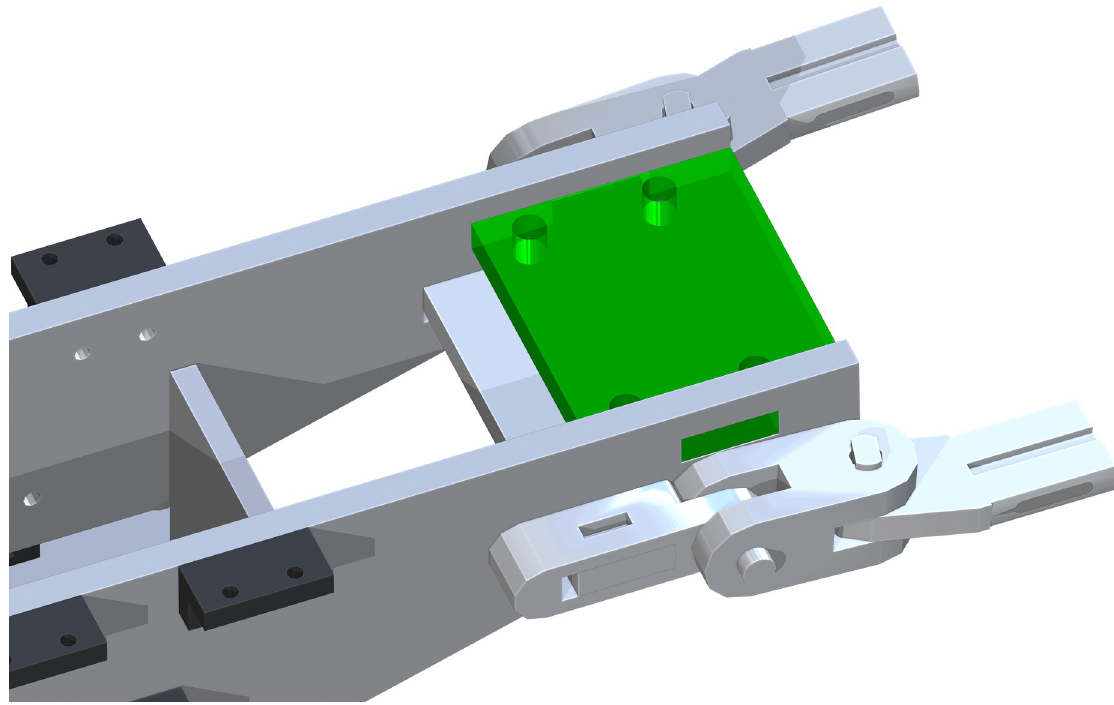
Fig 19. Addition of Peroneal Support to the Table Top Support.